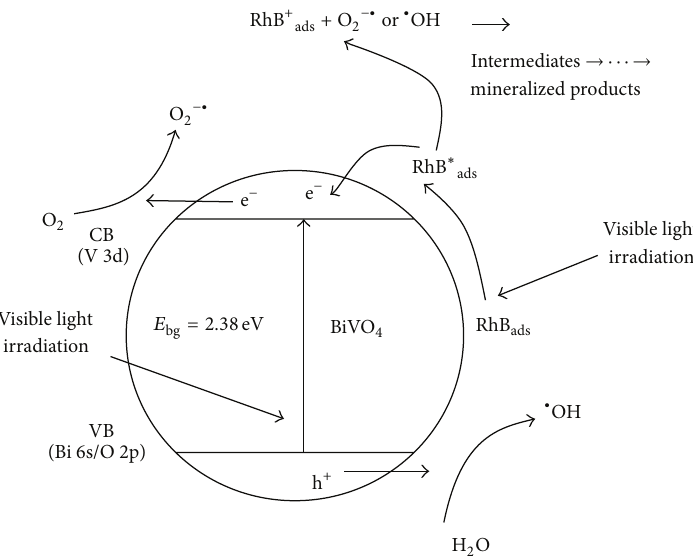
Figure 12: Photocatalytic mechanism of BiVO 4 (C+H-200-24) over RhB under visible light irradiation.